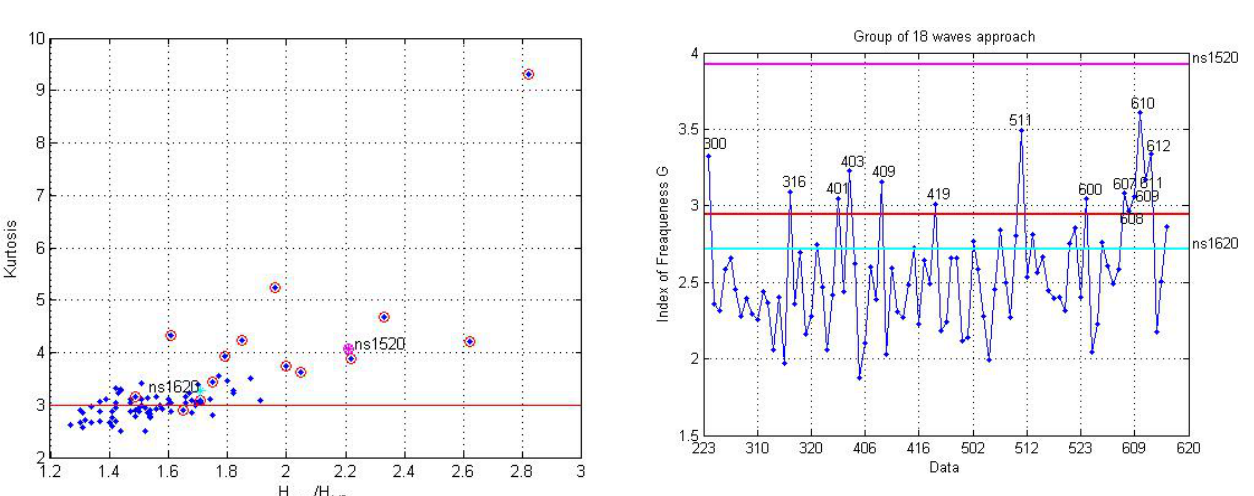
Figure 11 Calculated IFG: index of freaqueness based on Group of 18 waves approach corresponding to the data shown in Figure 7.